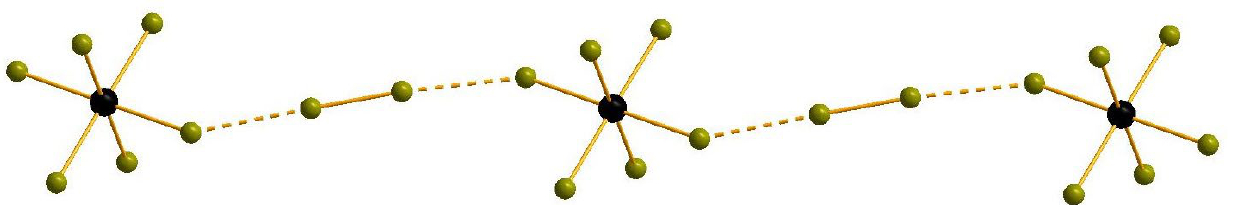
Figure 4. The system of non-covalent interactions in the structure of 4.